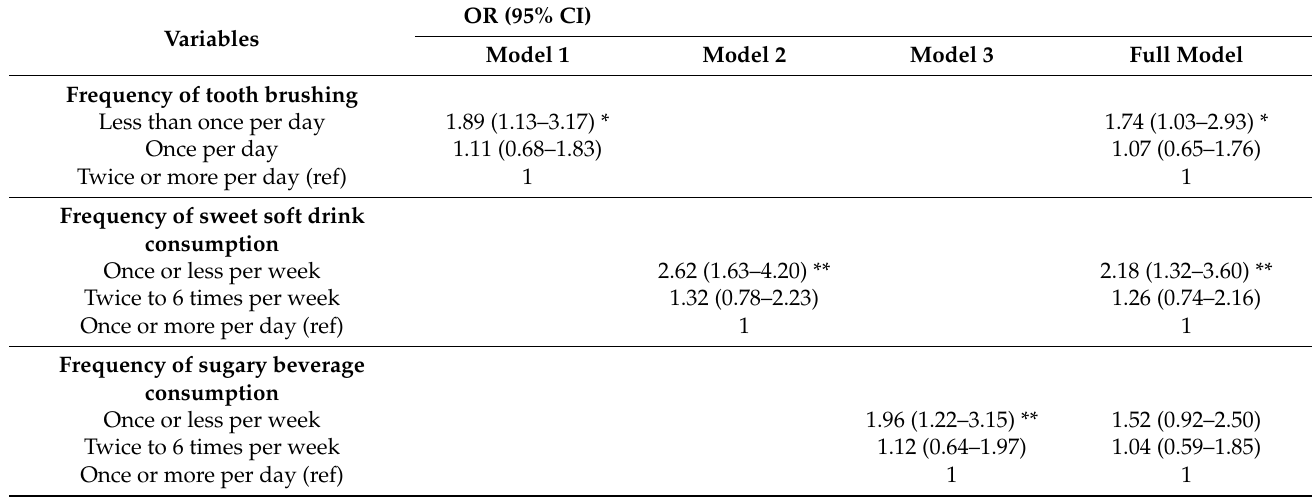
Table 4. Multiple logistic regression analysis by adjusting demographics factors.